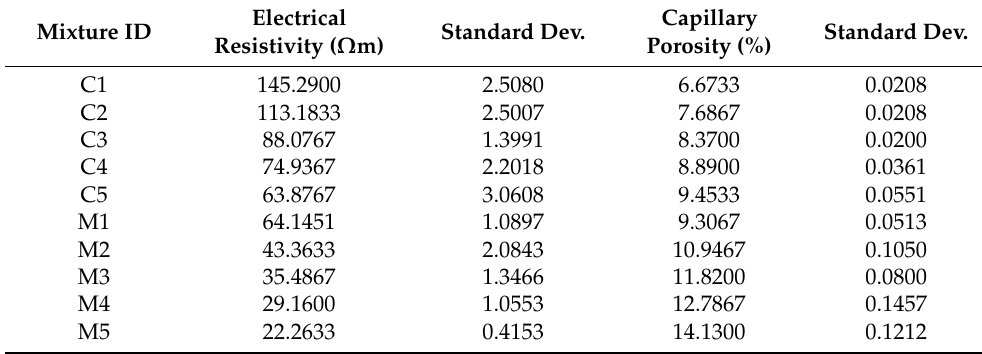
Table 3. Electrical resistivity and capillary porosity measurement results.